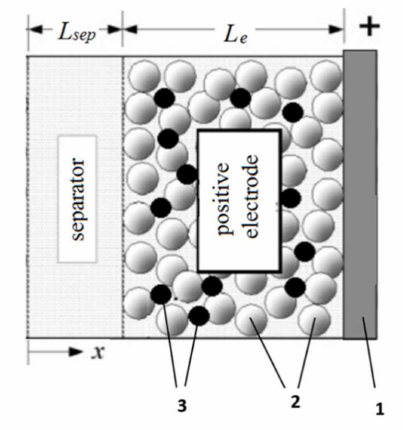
Figure 1. The model scheme, 1—a current collector, 2—particles of the active cathode material, 3—particles of added carbon